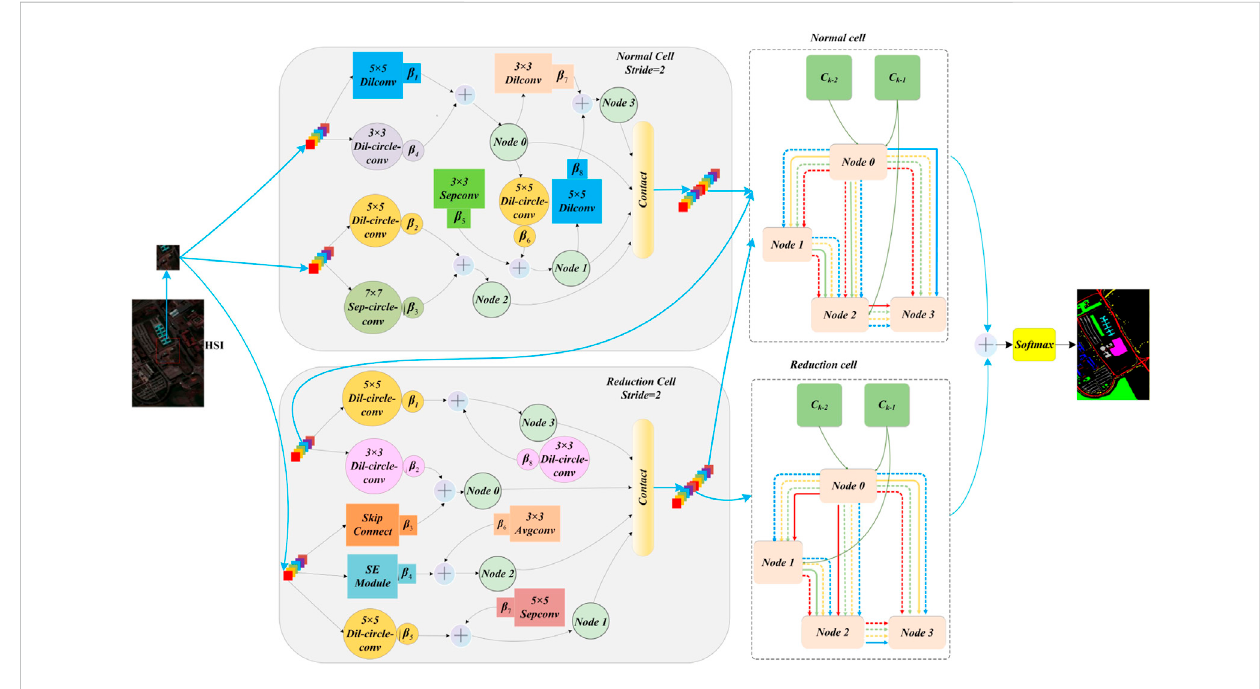
FIGURE 1 Overall framework of the proposed CK- β NAS-CLR